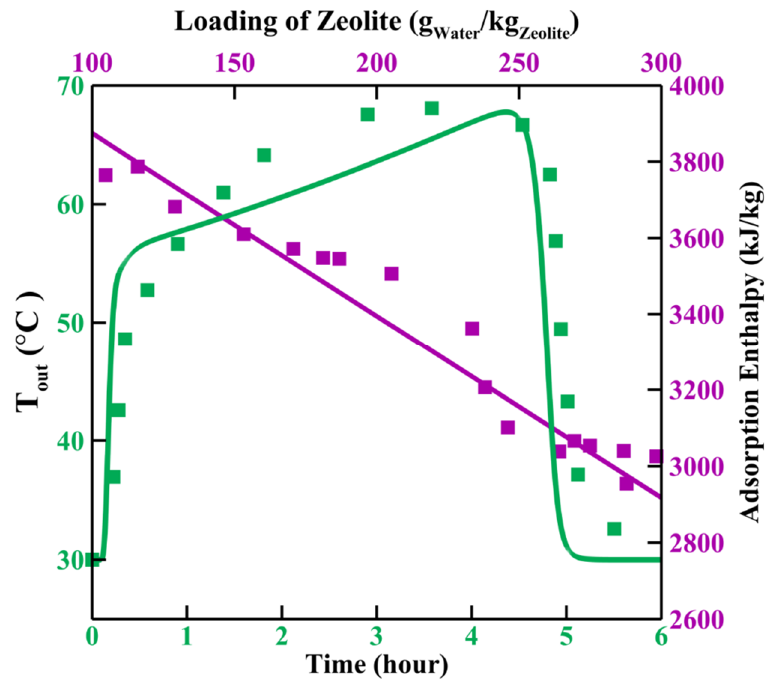
Figure 2. Validation of developed code at T ads = 30 °C and partial pressure of water vapor at 15 mbar.